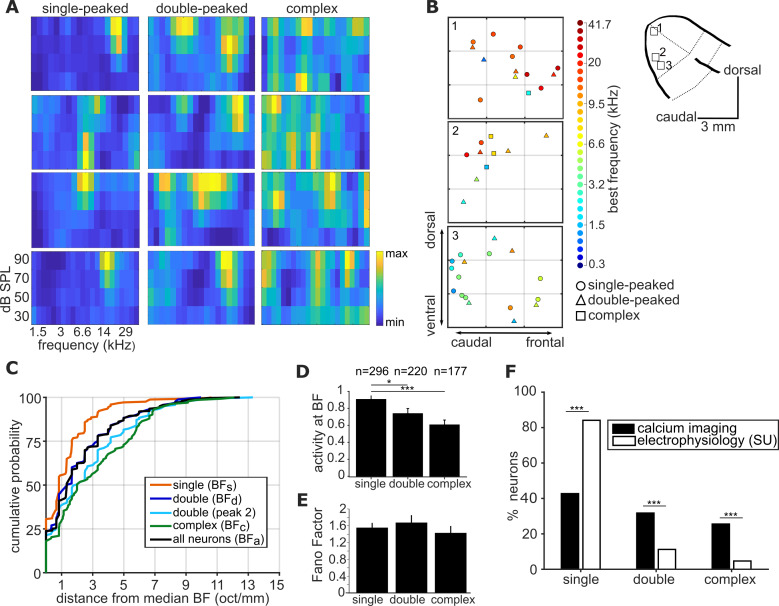
Complexity of frequency receptive fields predicts local variability in ferret A1 tonotopy.(A) FRA plots of four example neurons from ferret 6 for each of the three FRA classes. (B) Three 300 x 300 µm spatial maps of frequency-sensitive neurons along the tonotopic axis of ferret 6. Their anatomical locations within the ferret’s ectosylvian gyrus are represented in the schematic to the right. The color of each neuron indicates its BF (see color scale, right), and the shape corresponds to the classification of its FRA. (C) Cumulative probability plots of the difference (in octaves) between each neuron’s BF and the median BF of all neurons of the same FRA class in the same imaging field. Distributions for different FRA classes are plotted separately: single-peaked BFs; double-peaked BFd; double-peaked peak 2; complex BFc; and the BFa of all three FRAs together. (D) Magnitude of the trial-averaged response at BF, calculated from deconvolved fluorescence traces in two-photon imaging experiments. Responses were averaged across all neurons in each FRA class, pooled across imaging fields and ferrets (mean ± SEM). (E) Fano Factor values (mean ± SEM) for single-peaked, double-peaked, and complex neurons. (F) Percentage of neurons classified into each FRA class from two-photon calcium imaging (black) and single unit microelectrode recordings (white). The results of t-tests are indicated above the bars in (D) and (E), and Likelihood Ratio Tests in (F) (*p < 0.05 and *** p < 0.001).